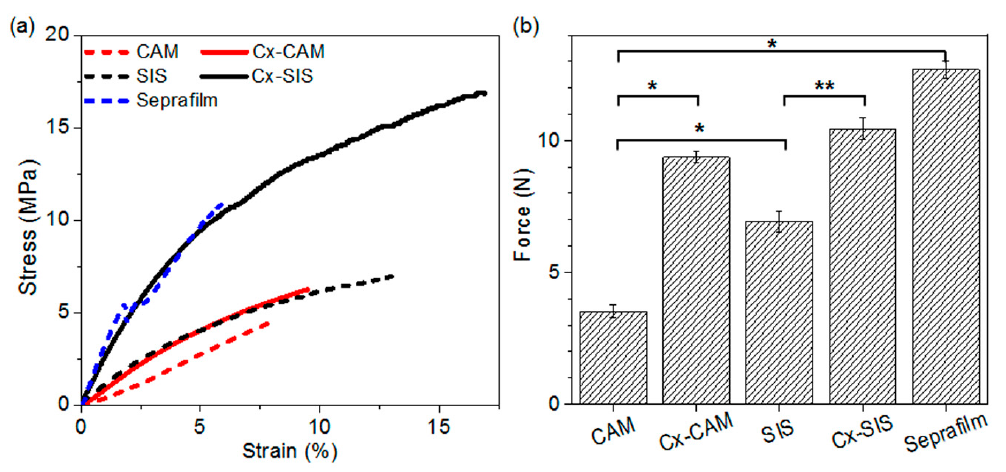
Figure 4. Images of a static droplet (side view) and contact angles of CAM, Cx-CAM, SIS, Cx-SIS films, and Seprafilm. 3.4. Antiadhesive and AntiproliferAtive Effects on HUVECs Seeded on Antiadhesive Films Because HUVECs are popular as an experimental model of vessel formation, the viability rates of HUVECs on CAM, Cx-CAM, SIS, and Cx-SIS films were examined for 7 days by the MTT assay. Seprafilm and a culture plate served as controls. First, fluorescent images of PKH67-labeled HUVECs were examined to confirm the attachment and proliferation of HUVECs (Figure 5a). Green fluorescent dot images, assignable to PKH67-labeled HUVECs, were examined.